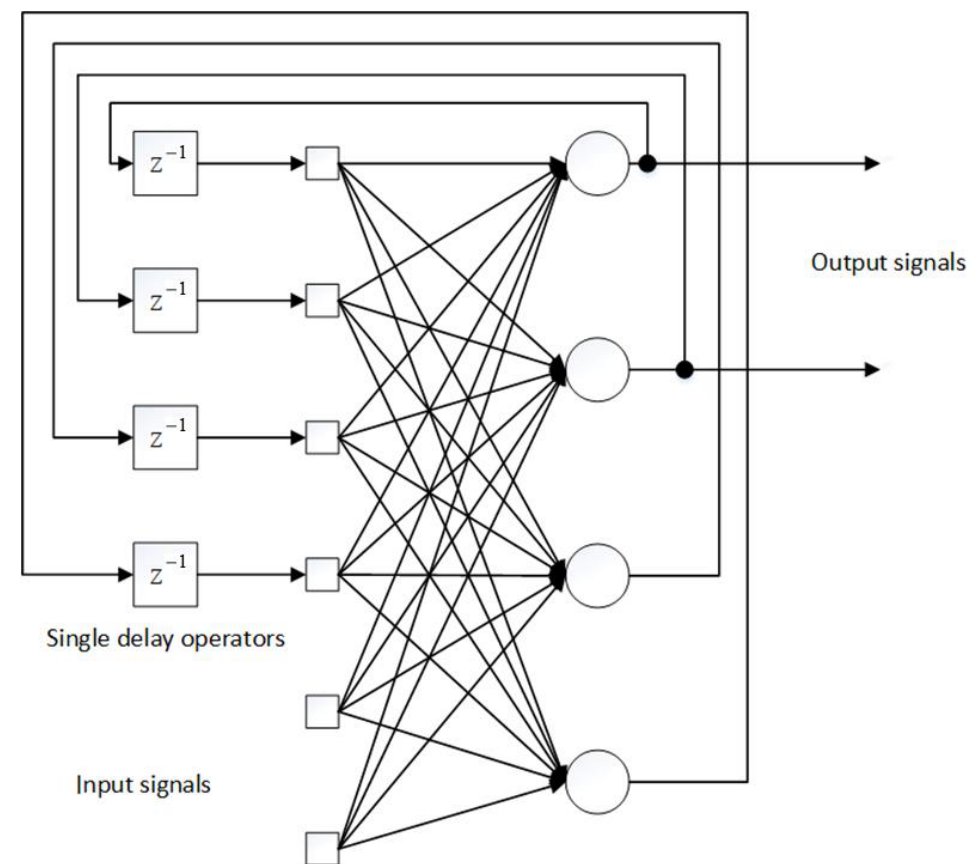
Figure 2. Neural network architecture for simulation the dynamics of the spread of the incidence of Lyme disease.